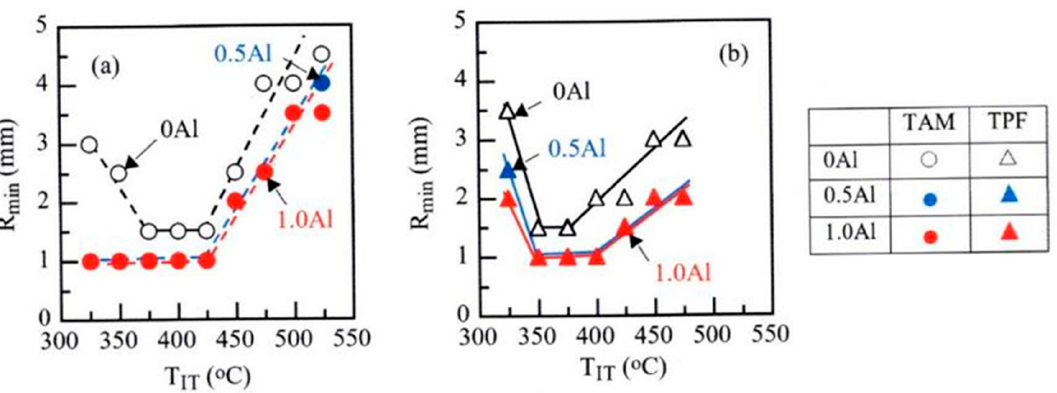
Figure 19. Variations in minimum bending radius ( R min ) as a function of isothermal transformation temperature ( T IT ) in ( a ) TAM and ( b ) TPF steels with the chemistry of 0.19C-1.54Si-1.51Mn-0.04Al (0Al), 0.20C-0.99Si-1.51Mn-0.49Al (0.5Al), and 0.20C-0.49Si-1.50Mn-0.99Al (1.0Al) [75]. ( a ) and ( b ) are reprinted with permission from ISIJ, copyright 2022. reprinted with permission from ISIJ, copyright